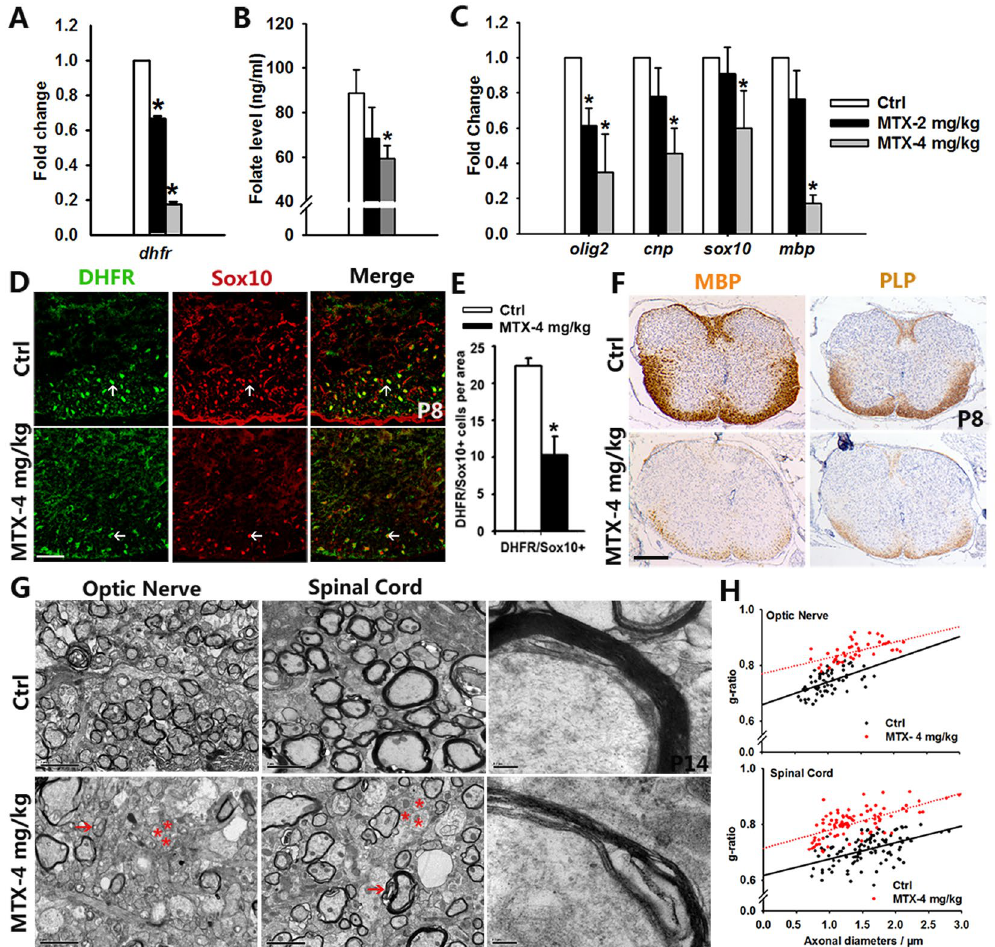
Figure 4. DHFR inhibition triggers evident oligodendrocyte damage and abnormal myelination. ( A , C ) qRT- PCR analysis of Dhfr mRNA level ( A ) or oligodendrocytes associated genes expression ( C ) in spinal cord from control and different doses of MTX-treated mice at P8. Data represents the mean ± S.D. (n > 3, * p < 0 . 05 compared with control, one-way ANOVA). ( B ) ELISA analysis of folate level in serum isolated from control and MTX-treated mice at P15. Data represents the mean ± S.D. (n = 5, * p < 0 . 05 compared with control, one-way ANOVA). ( D ) The spinal cords isolated from control and MTX-treated mice stained with DHFR and Sox10 antibodies at P8. The ventral parts showed in the images, and arrows indicate co-labeled cells. ( E ) Quantification of the numbers of DHFR + /Sox10 + cells per area (0.16 mm 2 ) in ( D ). Data represents the mean ± S.D. (n = 4, * p < 0 . 05 compared with control, student’s t test). ( F ) Immunohistochemistry analysis of spinal cords isolated from control and MTX-treated mice stained with MBP and PLP antibodies at P8. ( G ) Electron micrographs of spinal cord and optic nerve from control and MTX-treated mice at P15. Multilamellar myelin sheaths are compact around axons of control mice, whereas the myelin sheaths around axons from MTX-treated mice are essentially loose. Arrows represent the demyelinated axons, and asterisks indicate the unmyelinated axons. ( H ) G-ratio of individual axons as a function of axonal diameter in spinal cord and optic nerve from control and MTX-treated mice. (n > 100) Scale bars: 100 μ m ( D ), 200 μ m ( F ), 2 μ m (( G ) left), 0.2 μ m (( G )